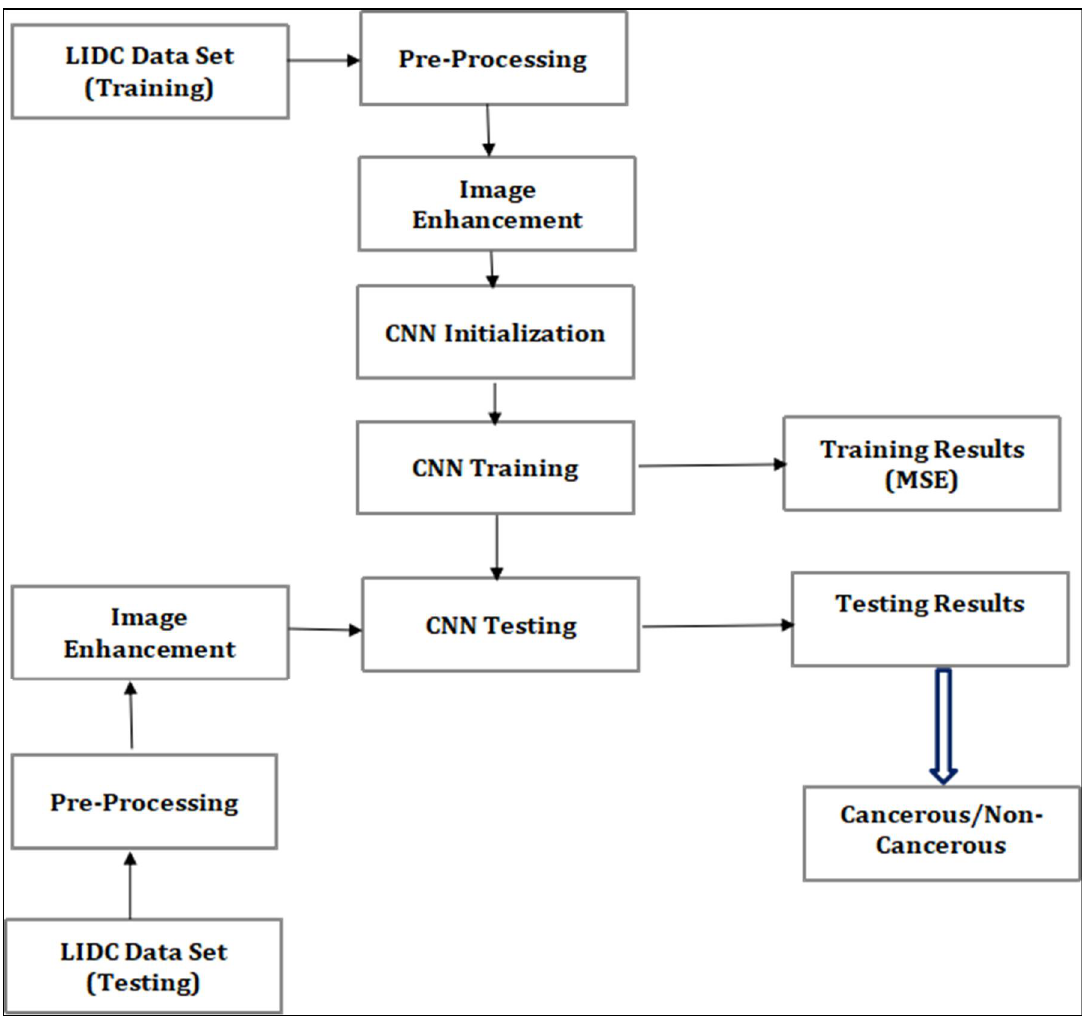
Figure 6. Flow chart of the proposed system.